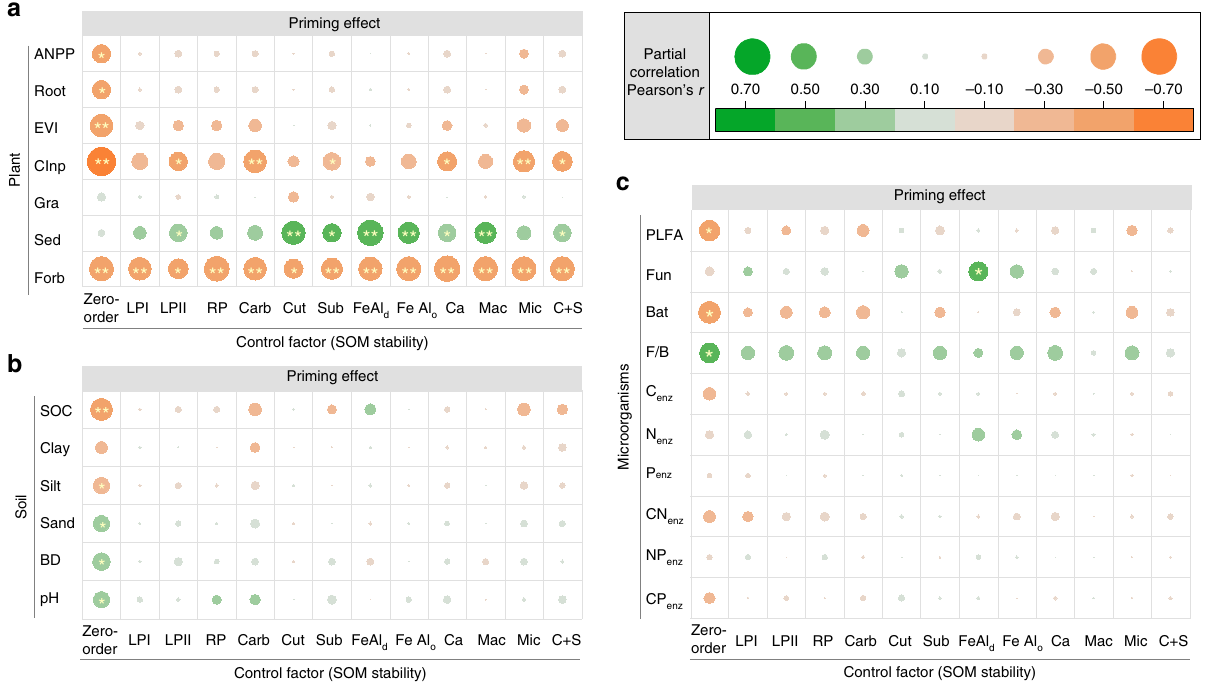
Fig. 2 Partial correlations between the priming effect and the plant, soil and microbial properties after controlling soil organic matter stability. The x -axis shows the zero-order (without controlling any factors) and the factors being controlled. The y -axis shows the factors ( a plant, b soil, c microbial properties) of which the correlations with the priming effect are examined. The size and colour of the circles indicate the strength and sign of the correlation. Differences in circle size and colour between the zero-order and controlled factors indicate the level of dependency of the correlation between the priming effect and the examined factor on the controlled variable (no change in circle size and colour between the controlled factor and zero-order = no dependency; a decrease/increase in circle size and colour intensity = loss /gain of correlation). ANPP, aboveground net primary productivity; EVI, enhanced vegetation index; CInp, C input amount; Gra, relative coverage of grass; Sed, relative coverage of sedge; Forb, relative coverage of forb; SOC, soil organic carbon content; BD, bulk density; PLFA: total PLFAs; Fun, fungal PLFAs; Bat, bacterial PLFAs; F/B, fungi/bacteria ratio; C enz , C-acquiring enzyme activity; N enz , N-acquiring enzyme activity; P enz , P-acquiring enzyme activity; CN enz , C:N ratio of enzyme activity; NP enz , N:P ratio of enzyme activity; CP enz , C:P ratio of enzyme activity; LPI, labile pool I; LPII, labile pool II; RP, recalcitrant pool; Carb, carbohydrate; Cut, cutin-derived compound; Sub, suberin- derived compound; FeAl d , molar ratio of free Fe/Al oxides to SOC; FeAl o , molar ratio of amorphous Fe/Al oxides to SOC; Ca, ratio of exchangeable Ca to SOC; Mac, proportion of C occluded in macroaggregates; Mic, proportion of C protected by microaggregates; C + S, proportion of C associated with clay + silt fractions. * p < 0.05; ** p <